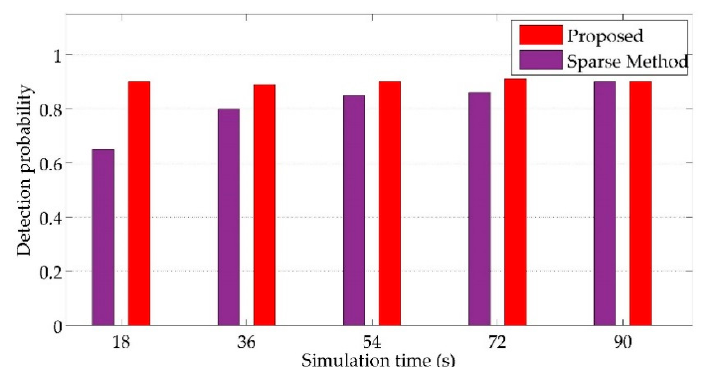
Figure 10. Analysis on the detection probability.